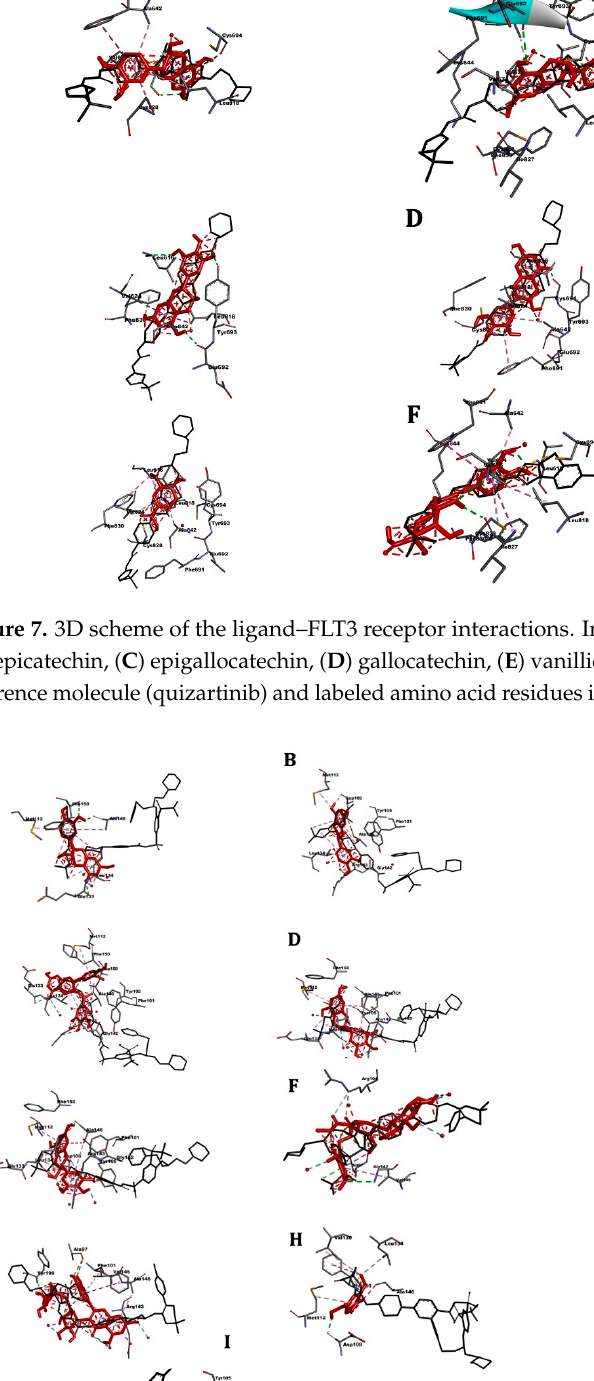
Figure 8. 3D scheme of the ligand–Bcl-2 receptor interactions. In red, tested molecule ( A ) Catechin, ( B ) Epicatechin, ( C ) epicatechin gallate, ( D ) epigallocatechin, ( E ) gallocatechin, ( F ) oleuropein,( G ) rutin, ( H ) vanillic acid, ( I ) chlorogenic acid; in black, reference molecule (navitoclax) and labeled amino acid residues interacting with the tested molecule.